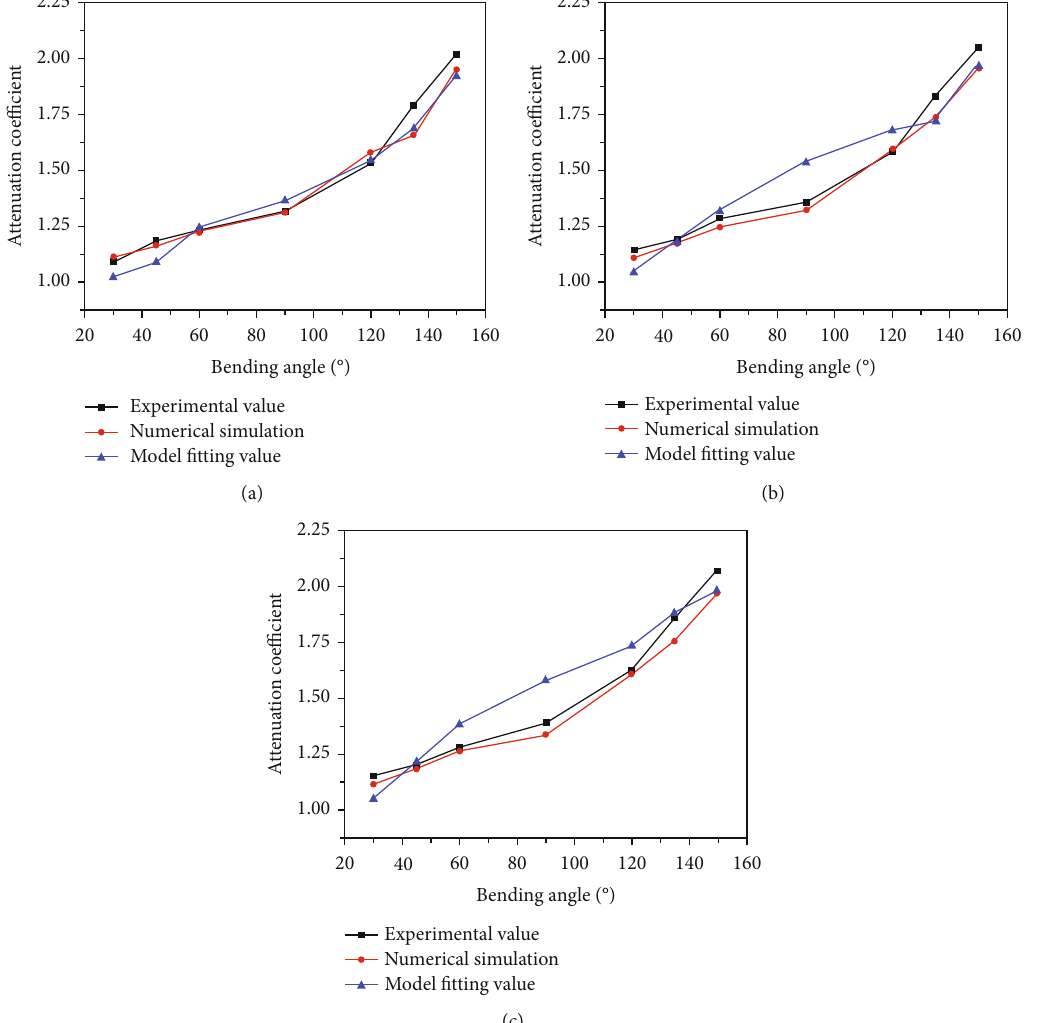
Figure 10: Comparison of numerical simulation, experimental results, and model fi tting values of the attenuation coe ffi cient: (a) 0.23m 3 gas volume, (b) 0.28m 3 gas volume, and (c) 0.31m 3 gas